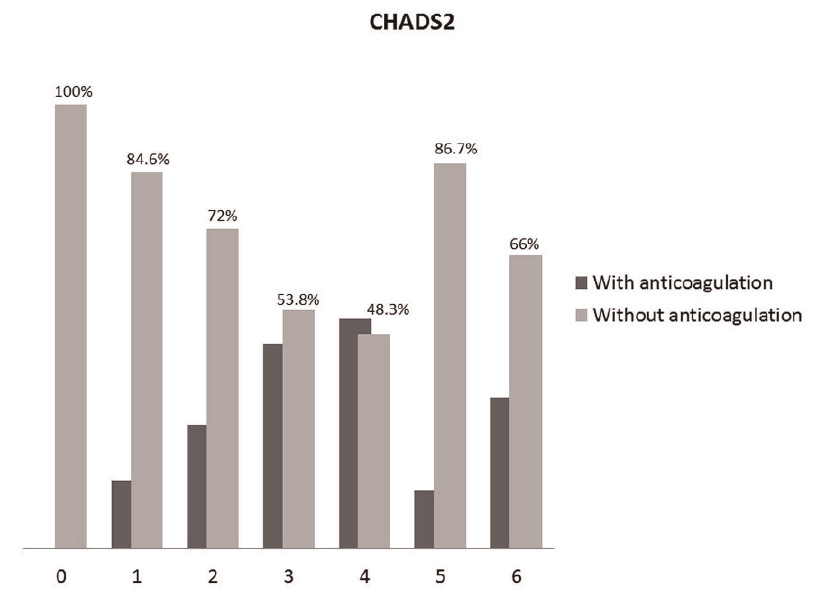
Figure 1 - Prevalence of the use of oral anticoagulants according to the CHADS2